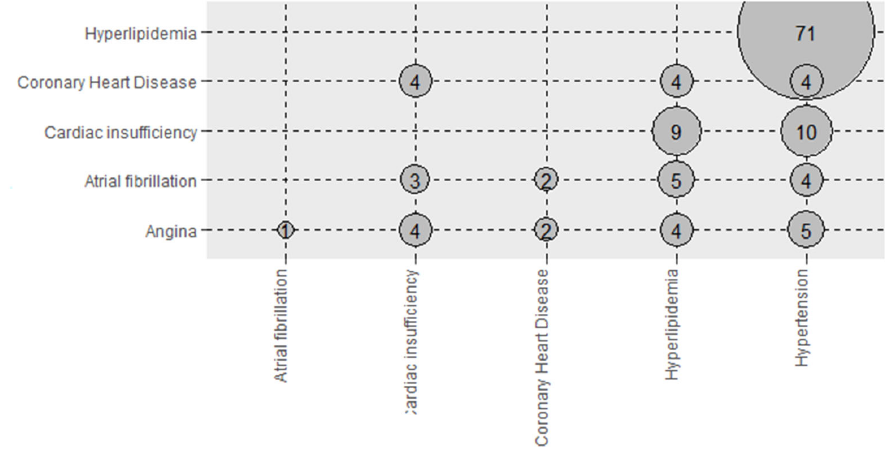
Figure 1. Combinations of cardiovascular diseases among people with at least two cardiovascular diseases.